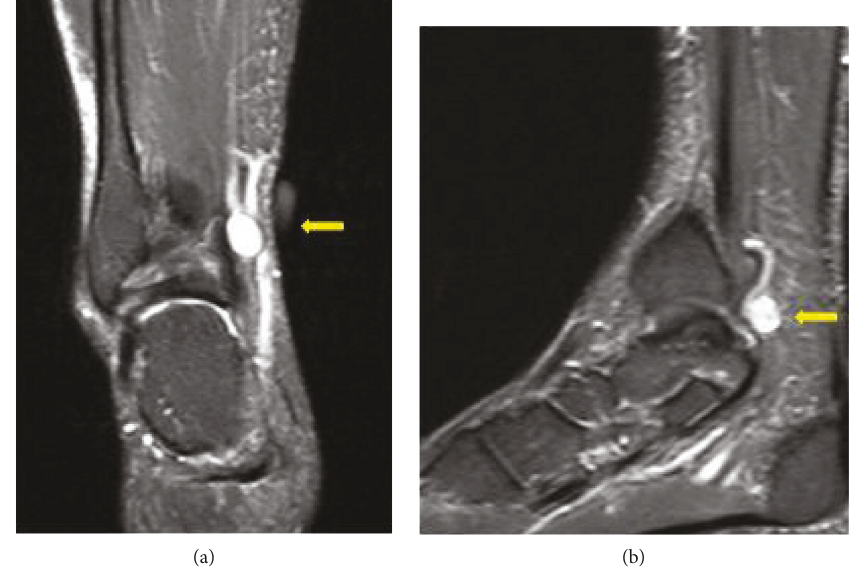
Figure 1: Well-de fi ned hyperintense lesion (depicted by arrows) seen involving the posterior tibial nerve in T2-weighted MRI (a, b).